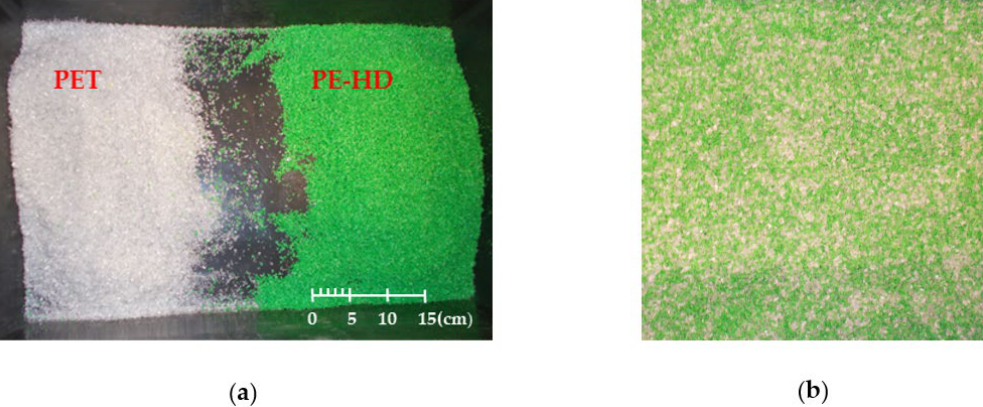
Figure 1. PET and PE-HD test material with grain size of 1.8–2.8 mm ( a ) before mixing; ( b ) after mixing.